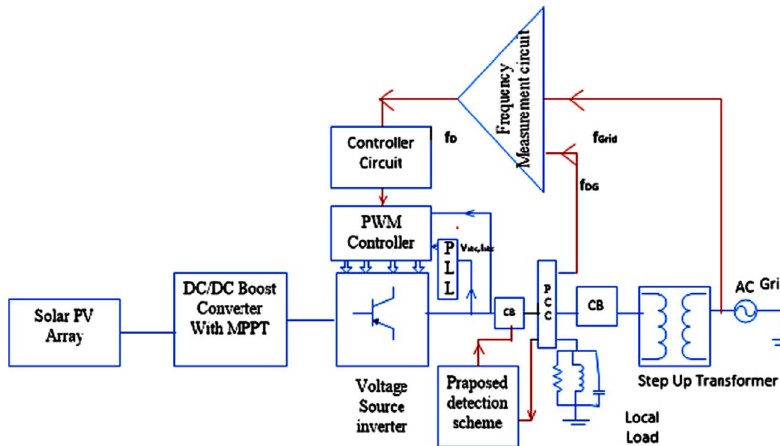
Fig. 2. Proposed grid-connected solar PV system.